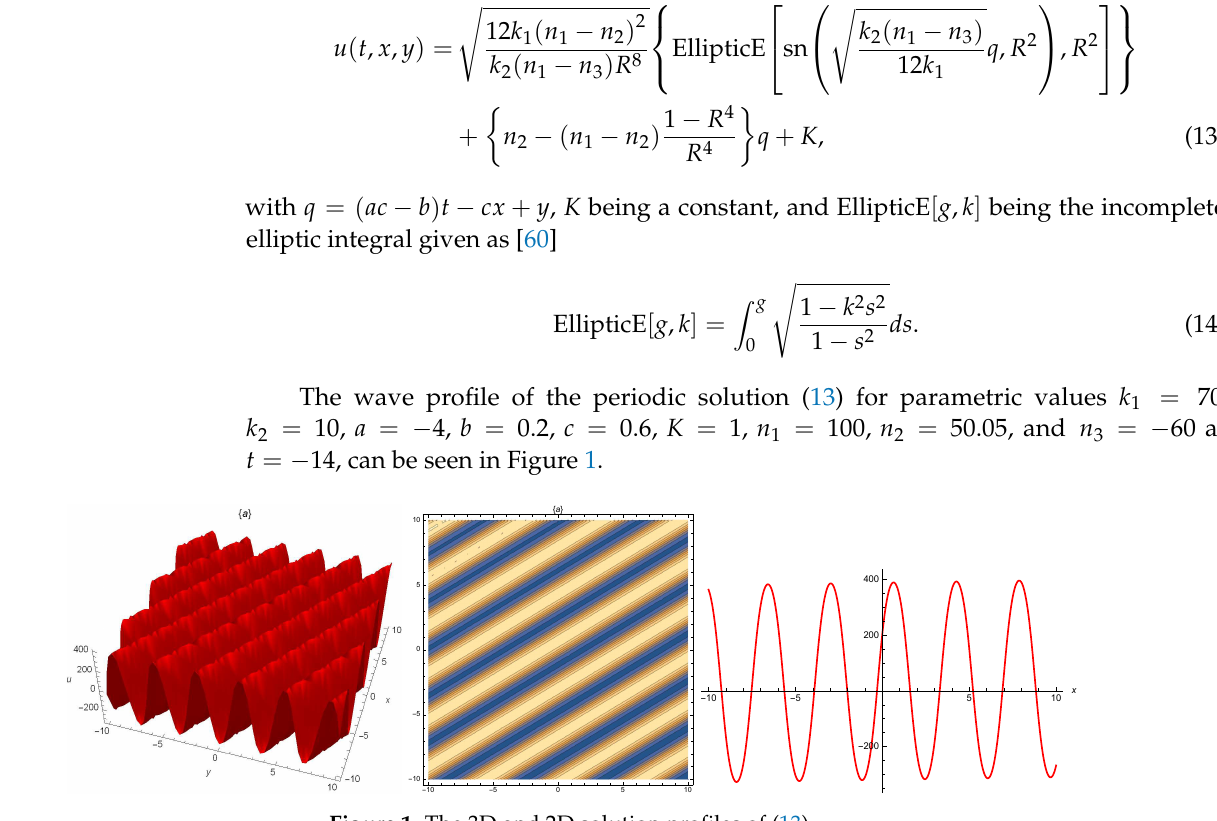
Figure 1. The 3D and 2D solution profiles of